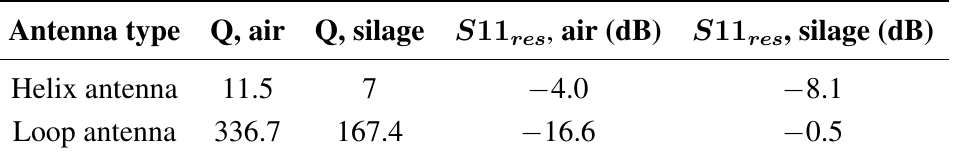
Table 2. Resonance frequency of the antennas in both air and silage. The helix antenna is significantly more affected by the silage than the loop antenna.